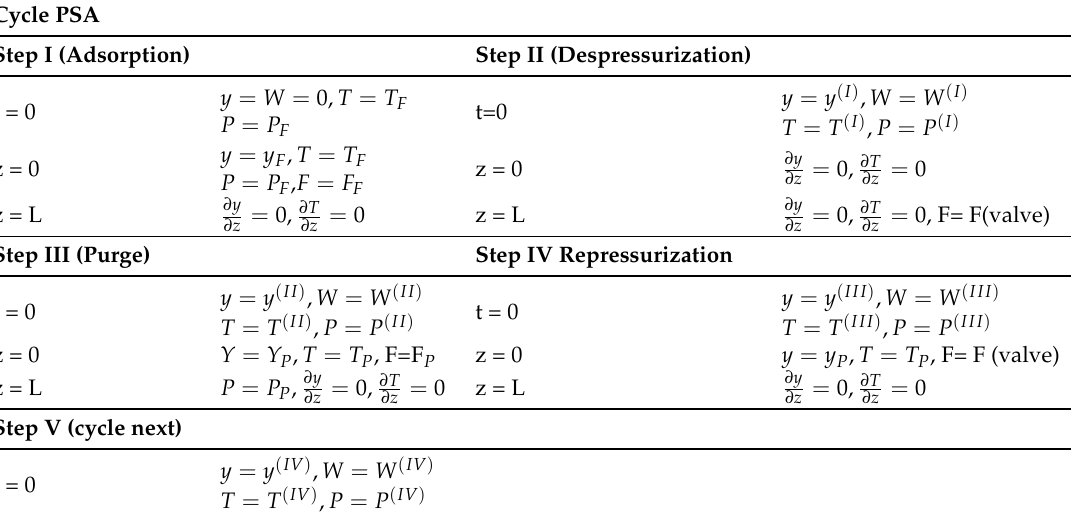
Table A10. Initial and boundary conditions for the four basic